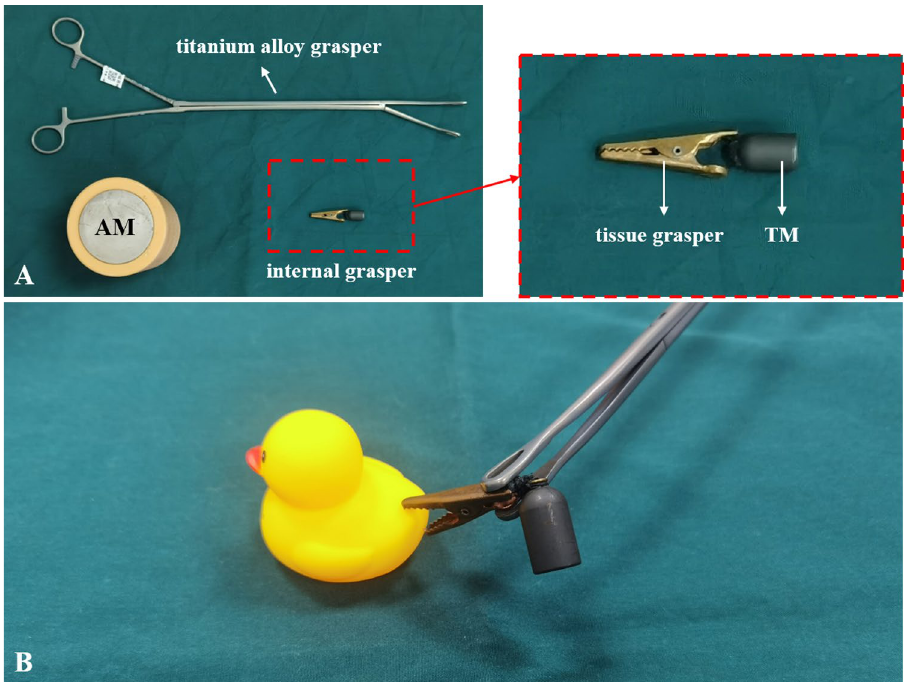
Figure 1. The magnetic anchor device. (A) Titanium alloy grasper, anchor magnet and internal grasper. (B) Titanium alloy grasper assists the internal grasper to clamp